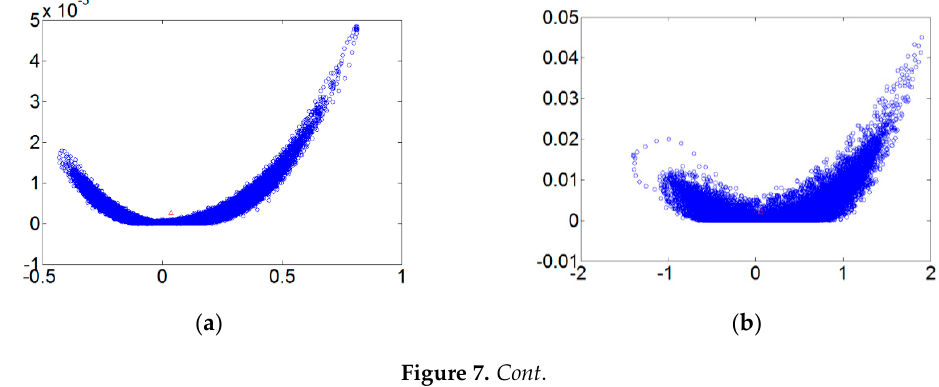
Figure 6. The order 0.9 fault dynamic error trace diagrams for all fault diameters. ( a ) Normal state; ( b ) fault diameter = 0.007; ( c ) fault diameter = 0.014; ( d ) fault diameter = 0.021.